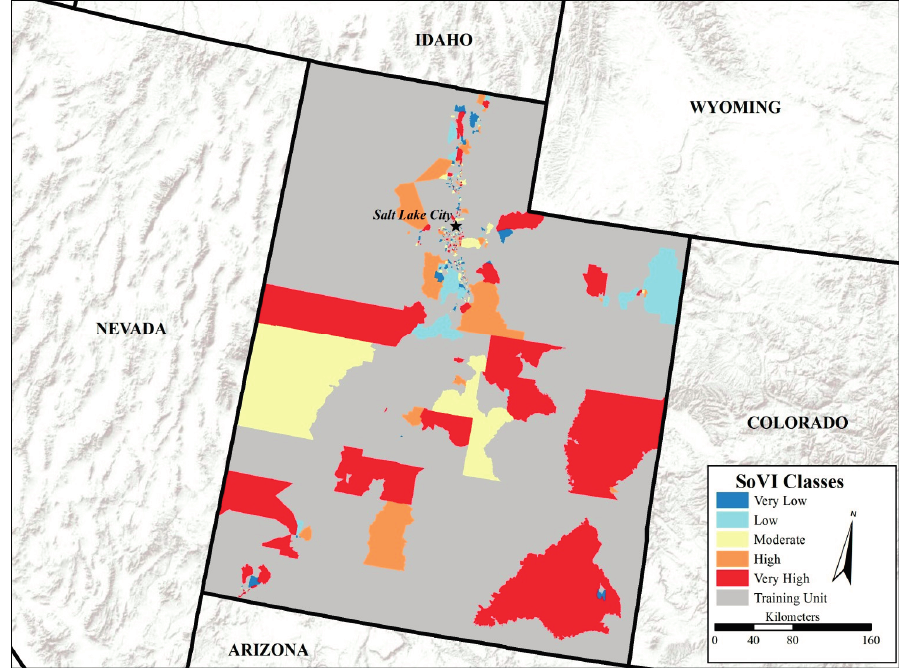
Figure 5. The SoVI for the state of Utah constructed using the Artificial Neural Network (ANN)-extended